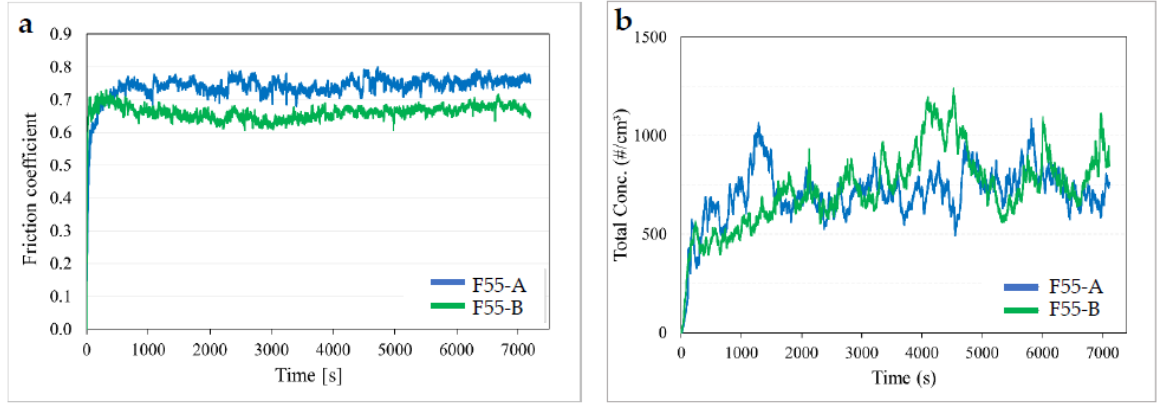
Figure 7. ( a ) Friction coefficient and ( b ) emissions related to friction materials A and B sliding against the coated GCI disc. the coated GCI disc.